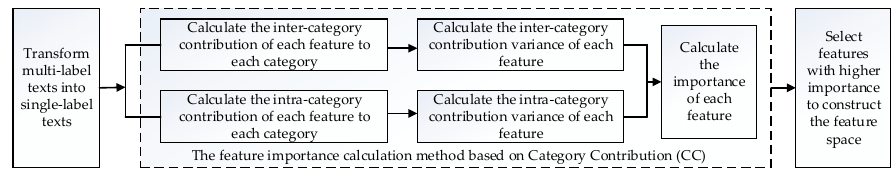
Figure 1. Multi-label text feature selection method based on feature importance.